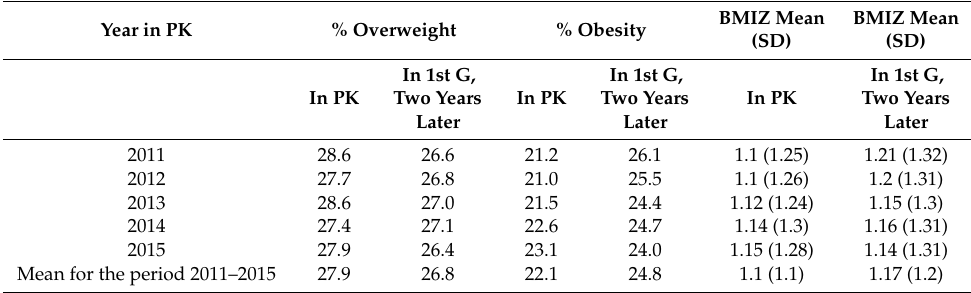
Table 2. Prevalence of overweight and obesity in boys in prekindergarten (PK) and in the 1st grade (1st G).